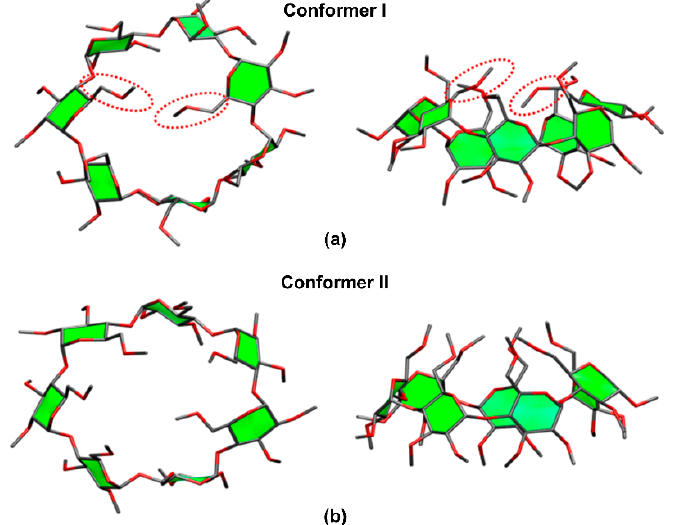
Figure 6. The most stable conformers of permethylated β -CD. Reproduced from Reference [56] by